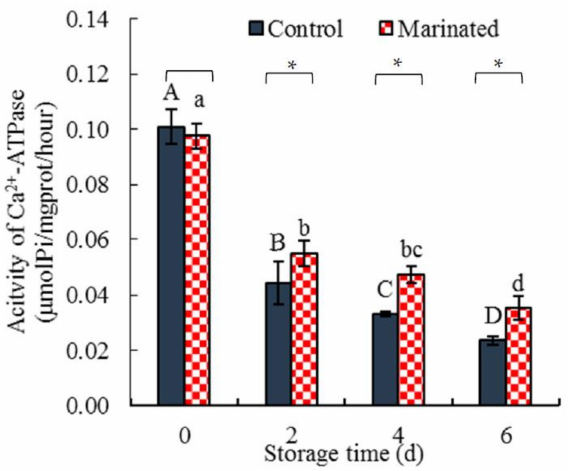
Figure 3. The activity of Ca 2+ -ATPase in the marinated pork and control. Values are presented as mean ± standard deviation. Different letters above the bars highlighting the standard deviations indicate significant differences ( p < 0.05). The asterisk indicates significant differences ( p < 0.05) between treatments for each